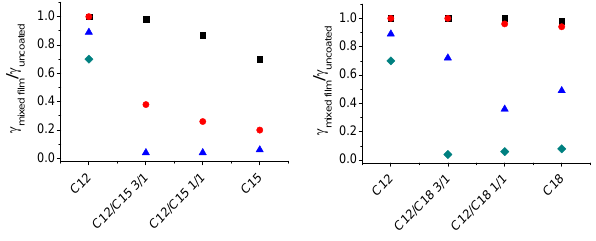
Fig. 8. Evolution of the ratio γ mixed film /γ uncoated for two- component coatings (a) C 12 /C 15 and (b) C 12 /C 18 at different tem- peratures of the evaporator ( T = 40 ◦ C: black squares, T = 50 ◦ C: red circles, T = 60 ◦ C: blue triangles and T = 70 ◦ C: green dia-